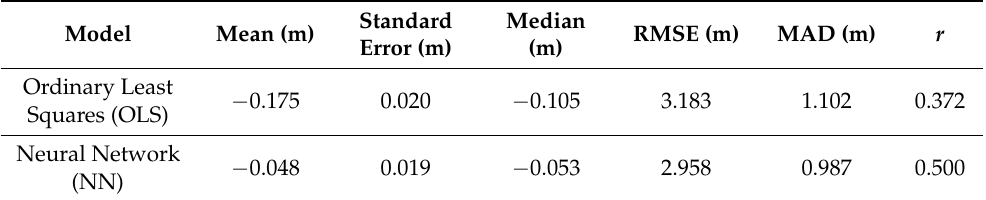
Table 2. Summary of OLS and NN accuracy on the unseen test dataset. All values relate to the difference between the model-based estimate of the LIDAR-SARIn adjustment and the